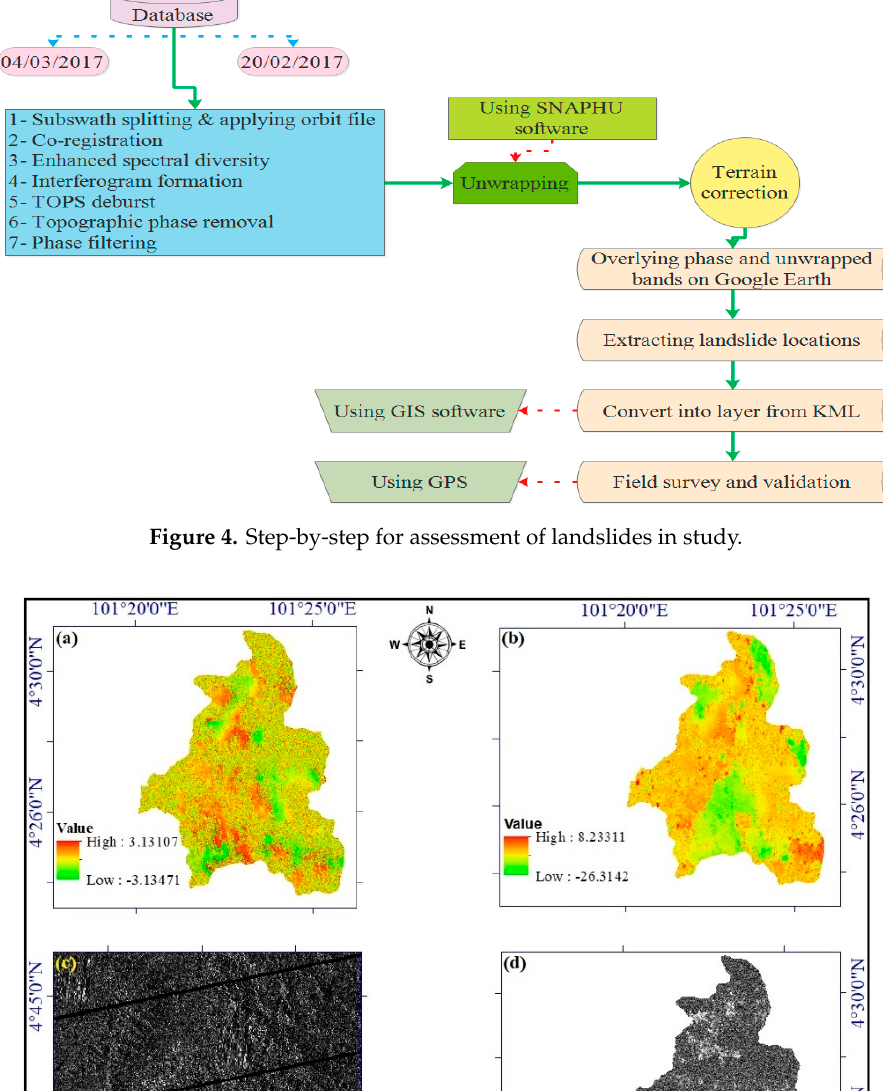
Figure 4. Step-by-step for assessment of landslides in study.